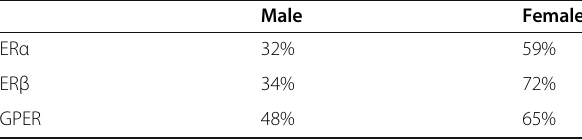
Table 2 Percentage of immunoreactive neurons in male and female TG